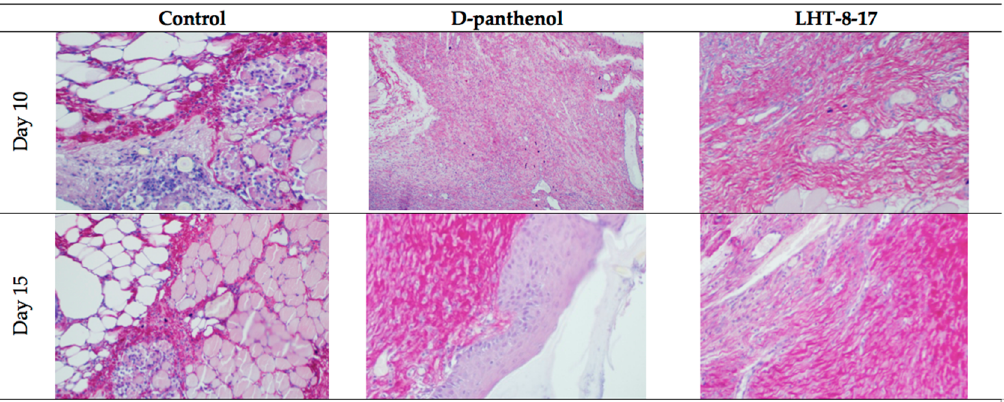
Figure 5. Van Geison’s staining of diabetic wound sections on days 10 and 15 of experimental topical therapy with LHT-8-17, db / db mice, 400× (n = 5 in each subgroup). Arrows point out positively-stained collagen. Thin and chaotically oriented collagen fascicles intrude muscular and fat layers in the control. Topical application of D-panthenol leads to the formation of a compact collagen layer. In the LHT-8–17 group on day 10, big masses of collagen fascicles form a single layer that transforms to a fibrotic condition by day 15.